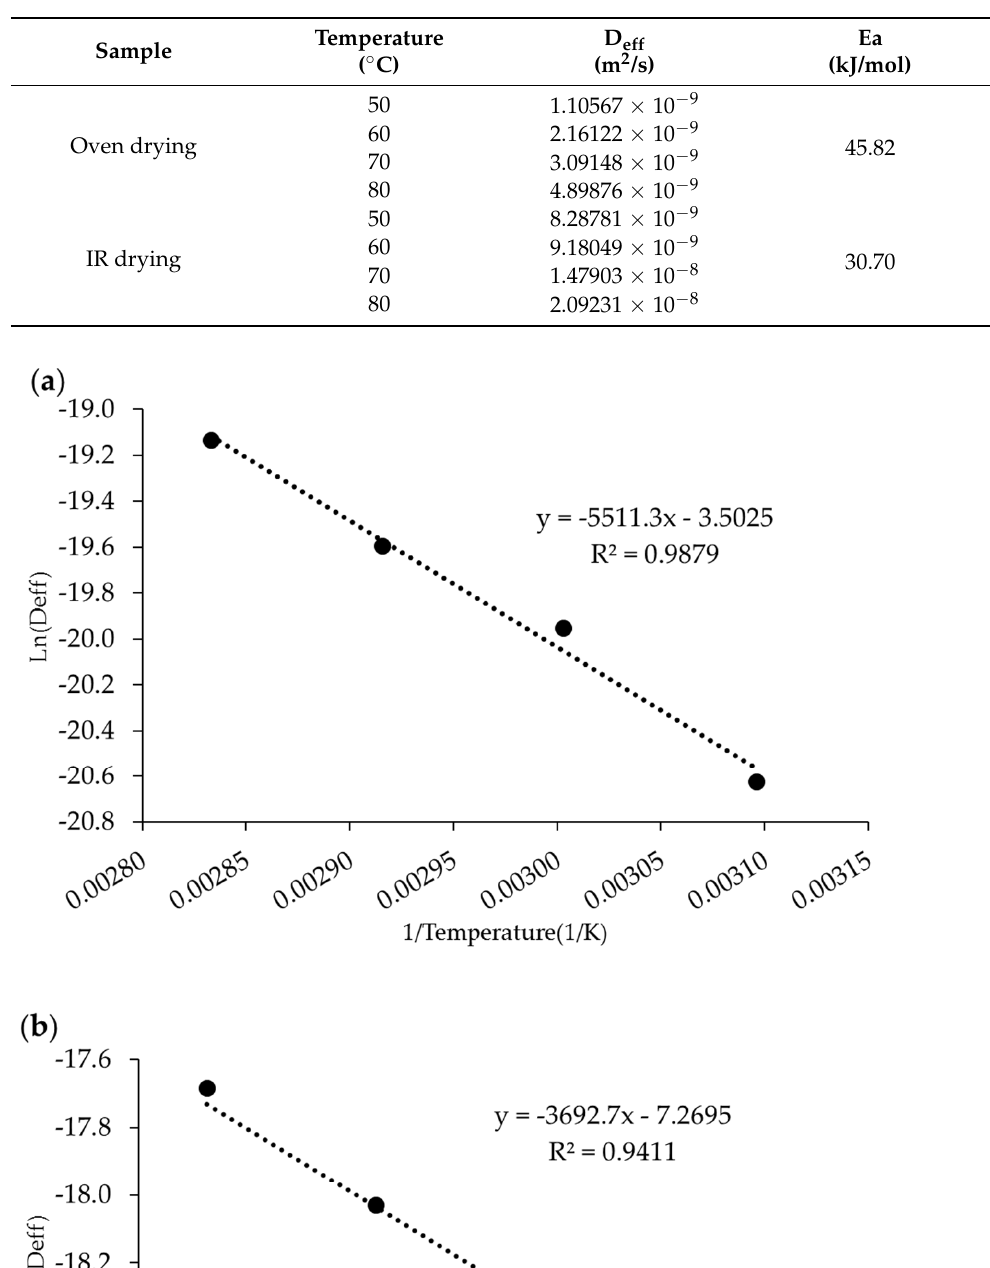
Table 3. Values of effective diffusivity obtained for RCM drying at different temperatures.